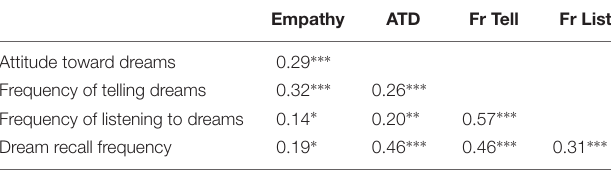
TABLE 3 | Pearson partial correlation co-efficients between trait empathy and dream variables, with age and sex partialled out, dfs =